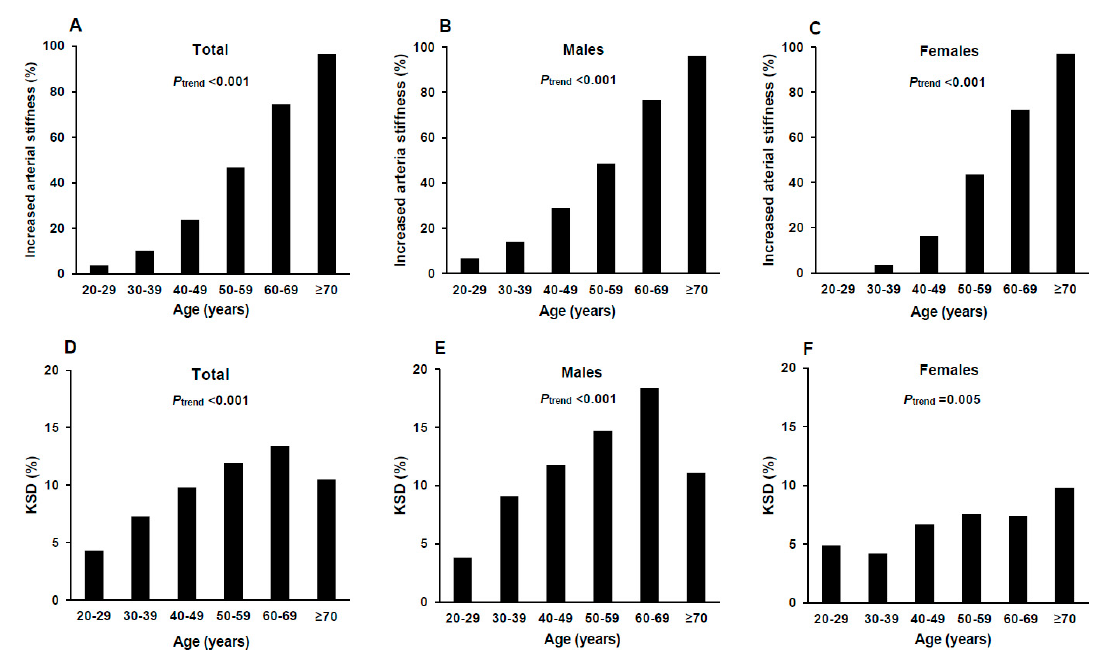
Figure 1. The prevalence of increased arterial stiffness and KSD by 10-year age group in total population ( A,D ), males ( B,E ) and females ( C,F ). KSD: kidney stone disease. The Mantel–Haenszel Chi-square test for trend was used to compare the prevalence of increased arterial stiffness and KSD among age groups.